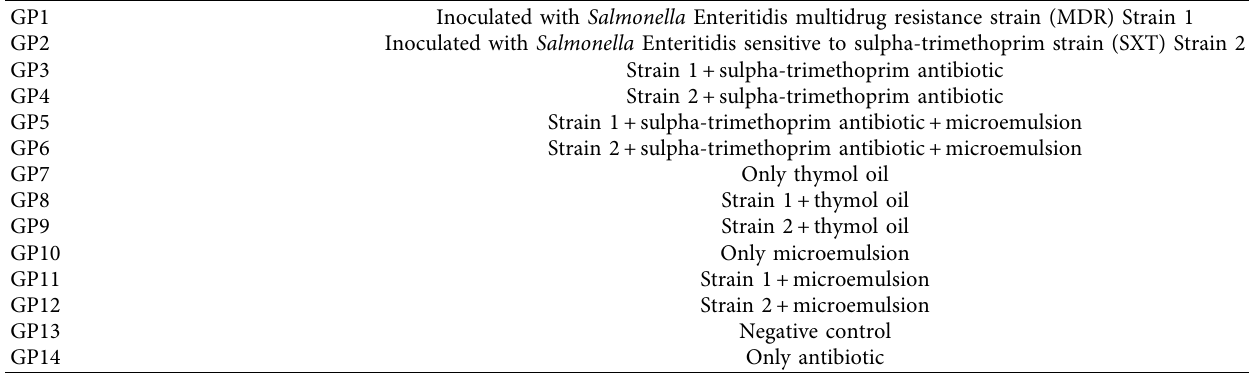
Table 1: Identification of groups of chicken in the in vivo challenge.